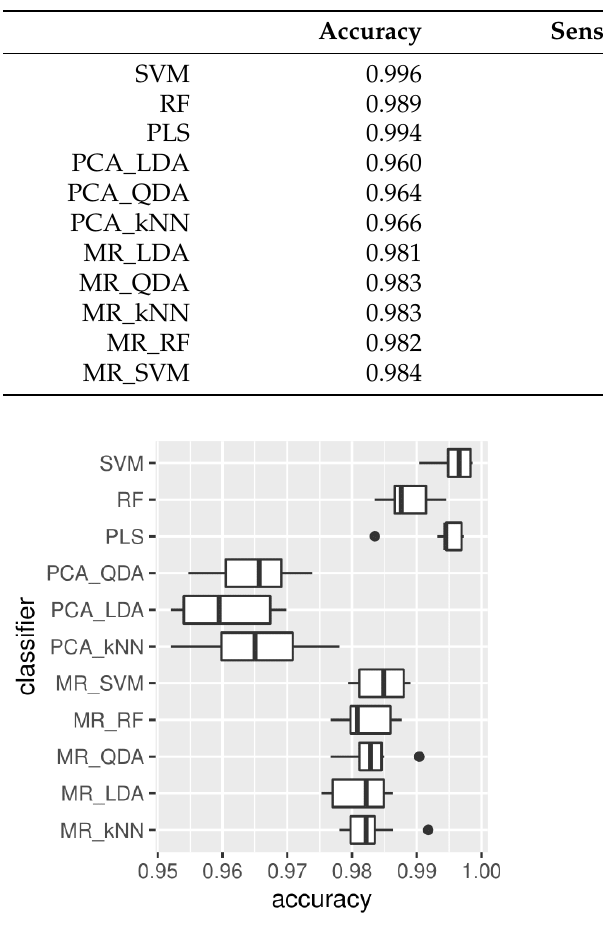
Figure 7. Classification accuracy of the 10 test sets in ten-fold cross-validation for the 11